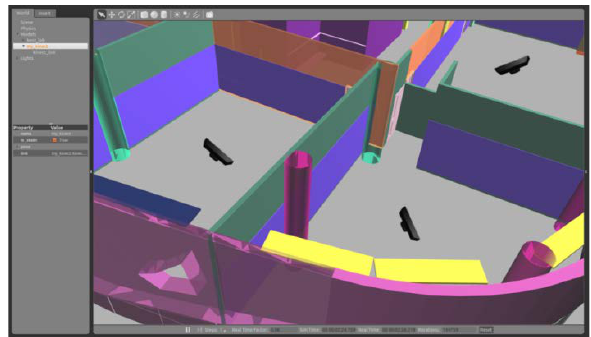
Figure 2. Equally spaced grid of simulated Kinect sensors capturing 360° synthetic panoramic images in the 3D CAD model of the Bergeron Centre